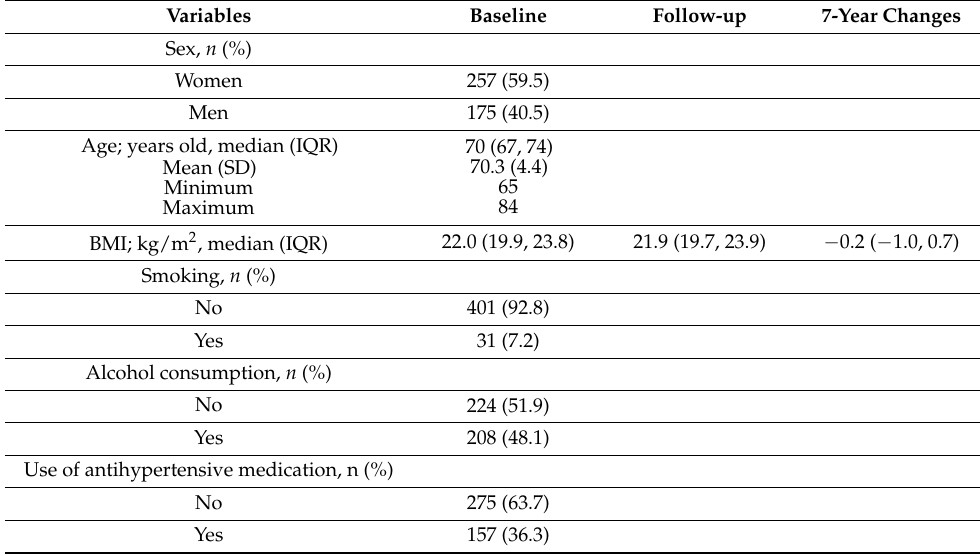
Table 1. Participants’ characteristics ( n =